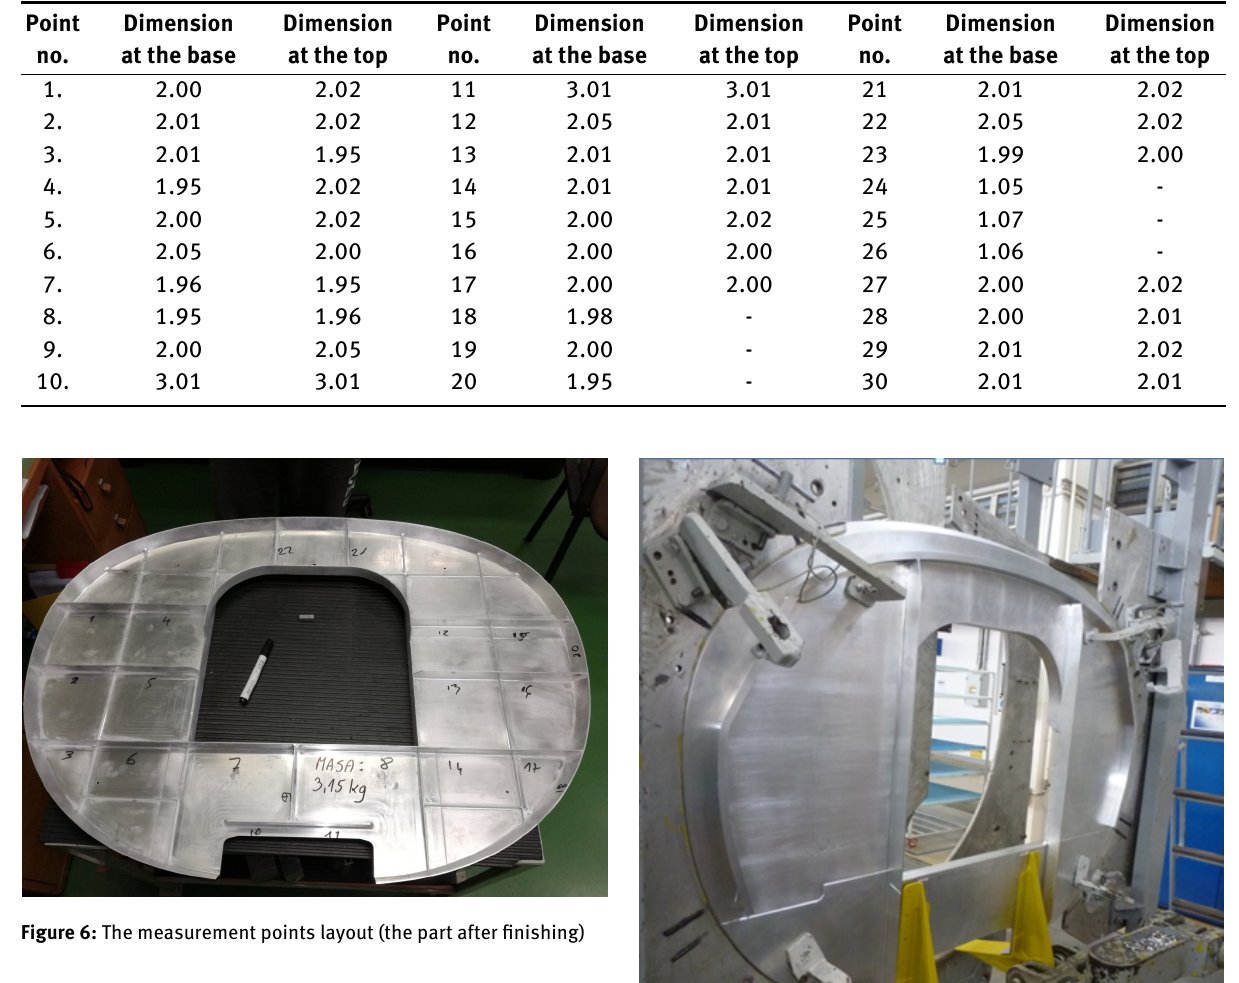
points is presented in Figure 6, while the measurement re- sults are presented in Table 3.